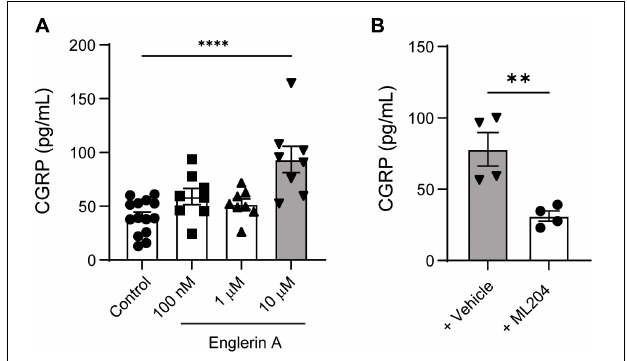
FIGURE 5 | TRPC4 activity controls CGRP release in cultured peripheral sensory neurons. (A) Englerin A (10 µ M) elicited CGRP release in the culture media of DRG neurons. ∗∗∗∗ p < 0.0001, two-tailed, unpaired Student’s t -test, n = 8–14 wells/group. (B) ML204 (100 µ M) significantly reduced Englerin A-evoked CGRP release in the culture media. ** p < 0.01, two-tailed, unpaired Student’s t -test, n = 4